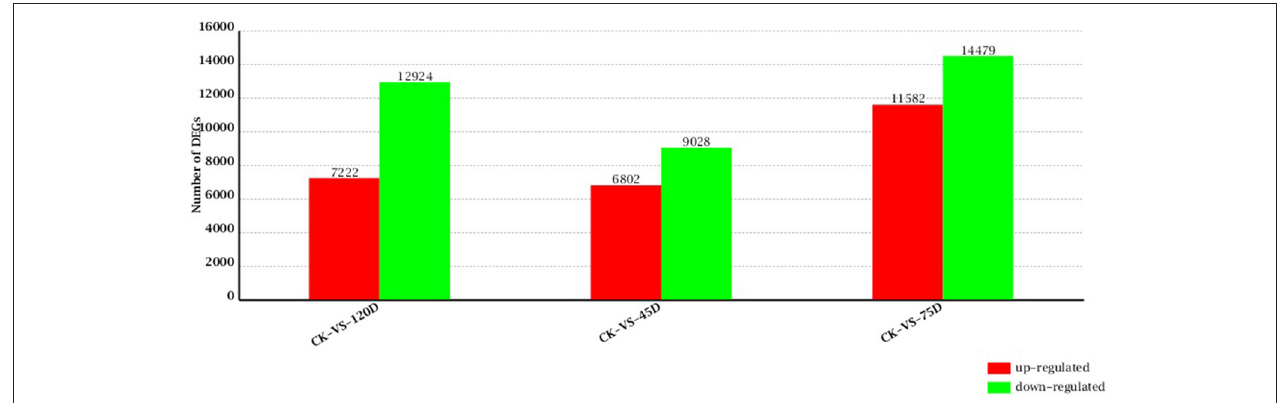
FIGURE 2 | Changes in gene expression profile of mango buds with the progression of F. mangiferae infection. The numbers of up- and down-regulated genes in 45D, 75D, and 120D compared to CK are